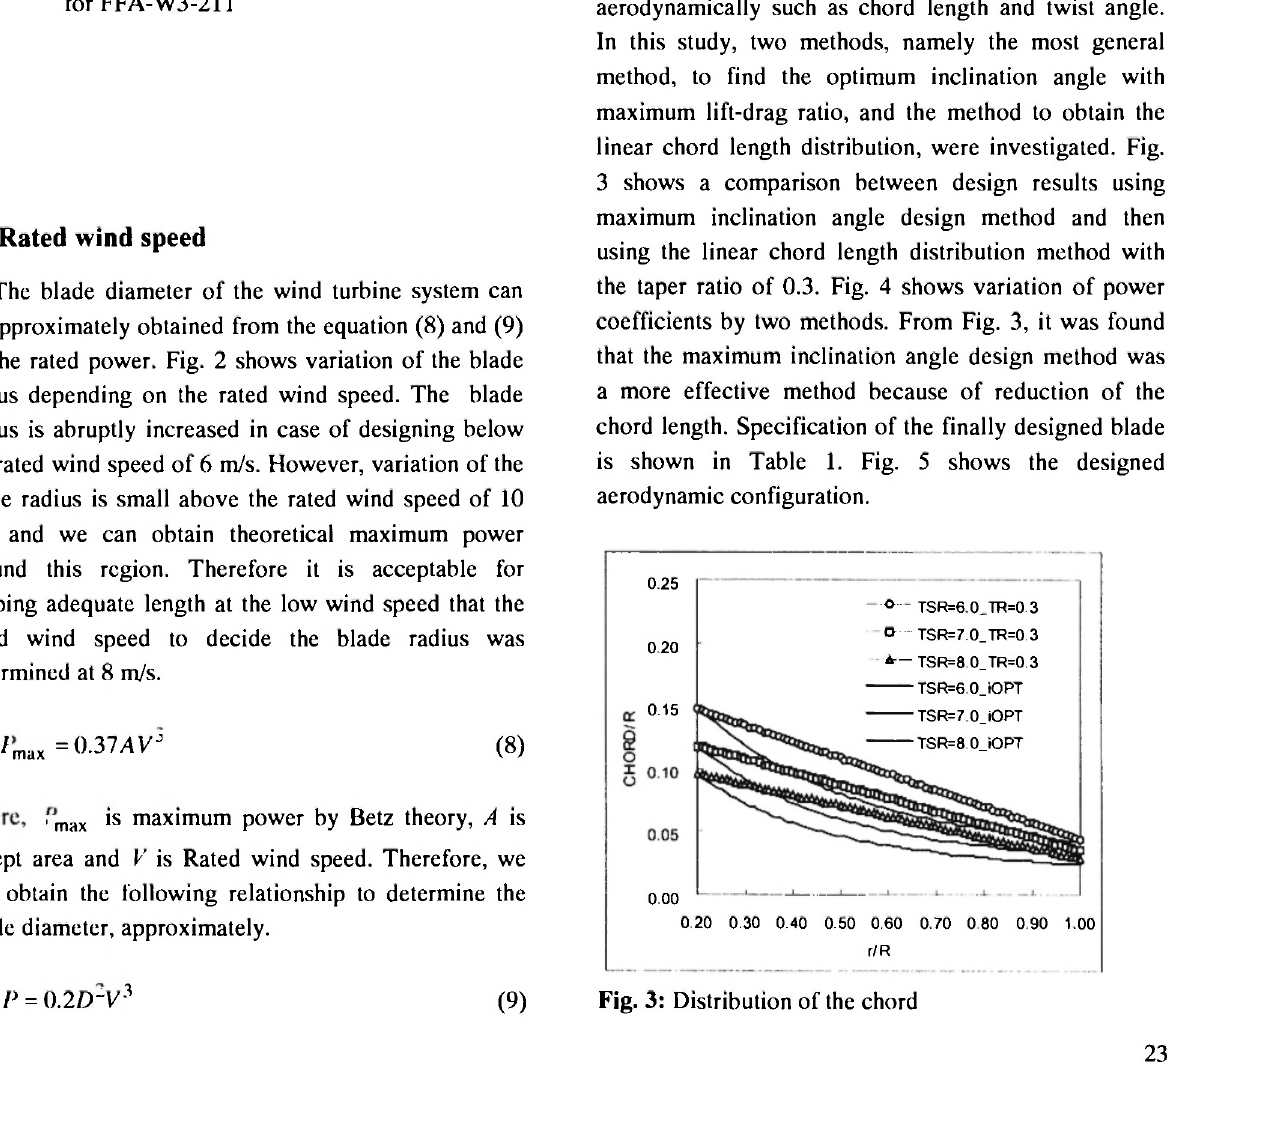
Fig. 1: Airfoil shape and aerodynamic characteristics for FFA-W3-211